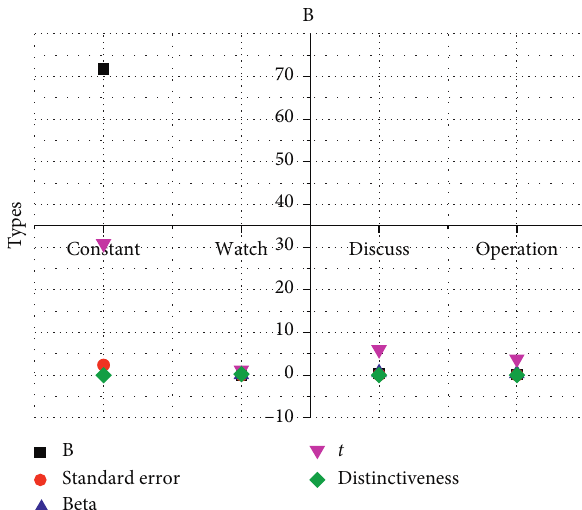
Figure 8: Attitude estimation model performance improvement.